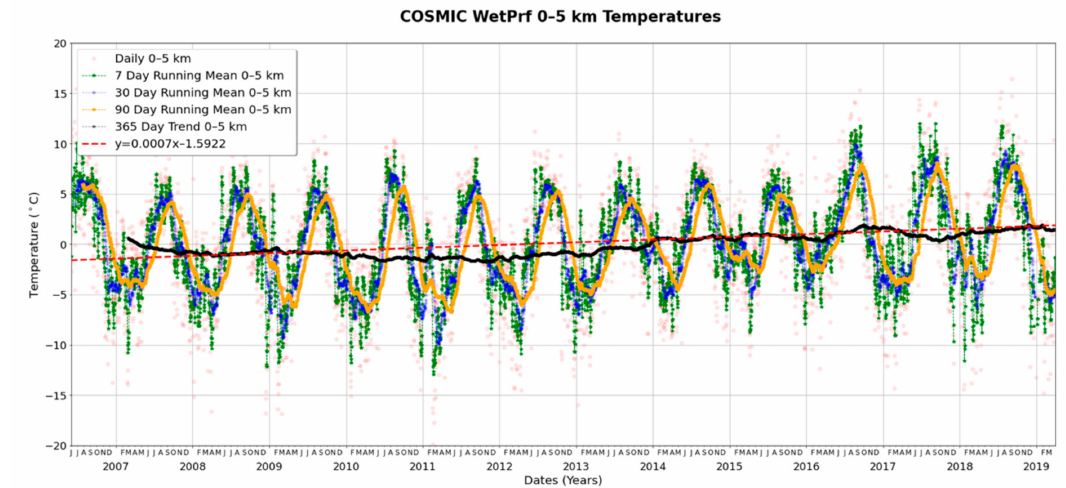
Figure 4. COSMIC temperature evolutions (i.e., 0–5 km) in the target